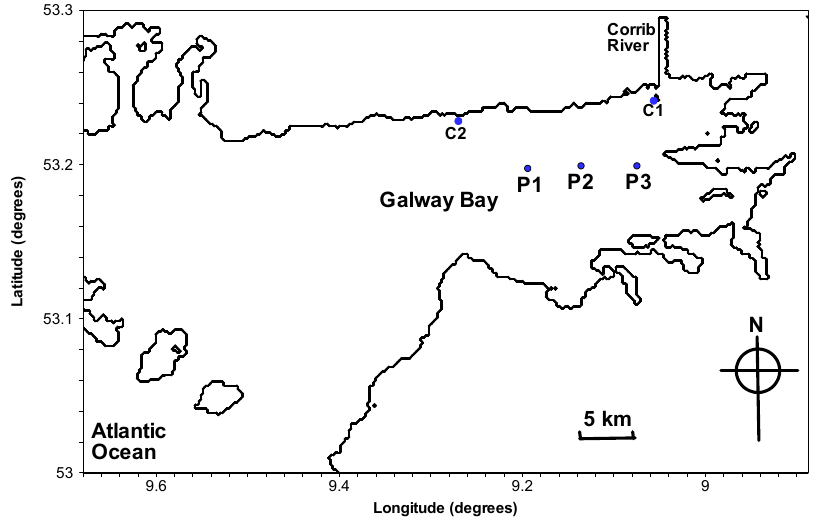
Figure 1. Galway Bay domain; (C1 and C2 indicate radar stations; P1–P3 indicate three analysis points).